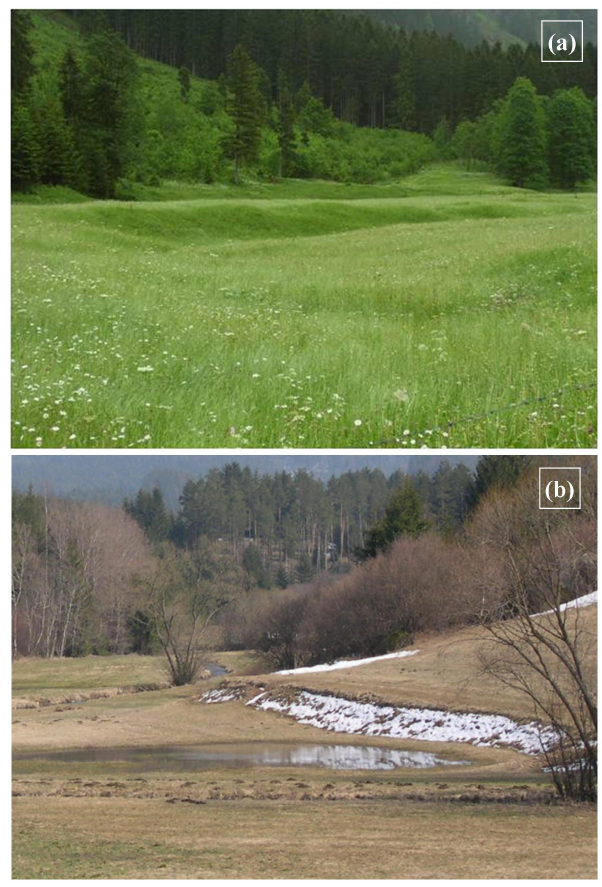
Fig. 6. Examples of feasible locations for micro-ponds in the catch- ments: (a) Upper Iller and (b)